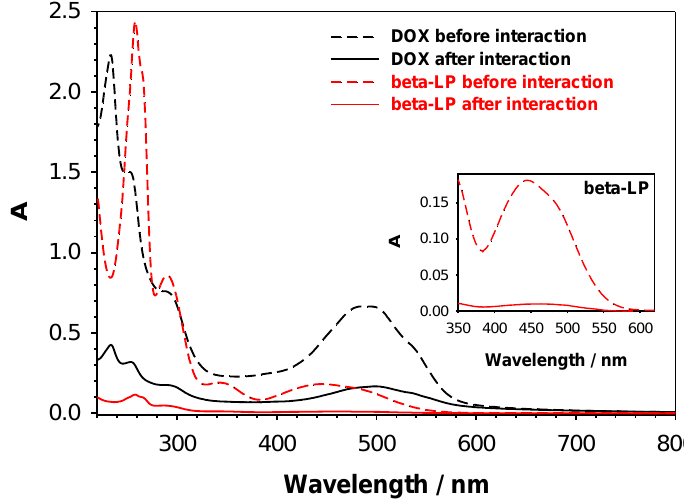
Figure 3. Dependences of absorbance (A) on wavelength for DOX and beta-LP solutions before and after interaction with PEI- β CD- α CD-FA nanoconjugate. Inset: Enlarged spectra for beta-LP. Experimental conditions: 0.02 M PBS (pH 7.4); C initial DOX = 100 µM; initial C = 100 µM.